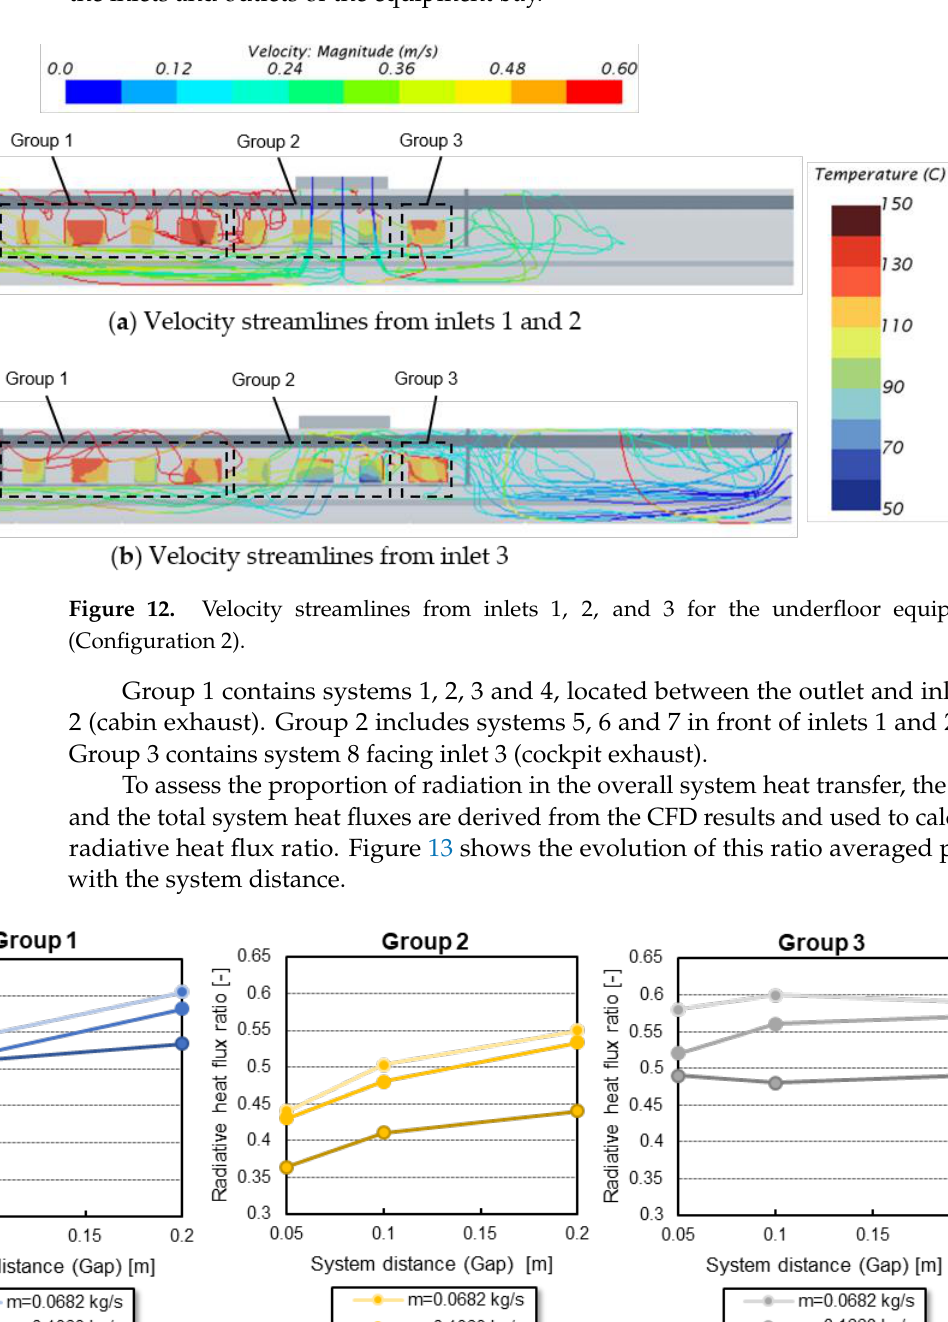
Figure 14. Velocity contour for Cases 1, 2, and 3 of the underfloor equipment bay (Configuration 2) for increasing gap distances and a constant mass flow rate. For group 3, the radiative heat flux ratio stays almost constant with the gap width variation between the system. The radiative heat flux ratio is less sensitive to the gap width than the other groups. Since only one system is in the group, its interaction with the other system is less critical as it has only one side facing another system. Indeed, the